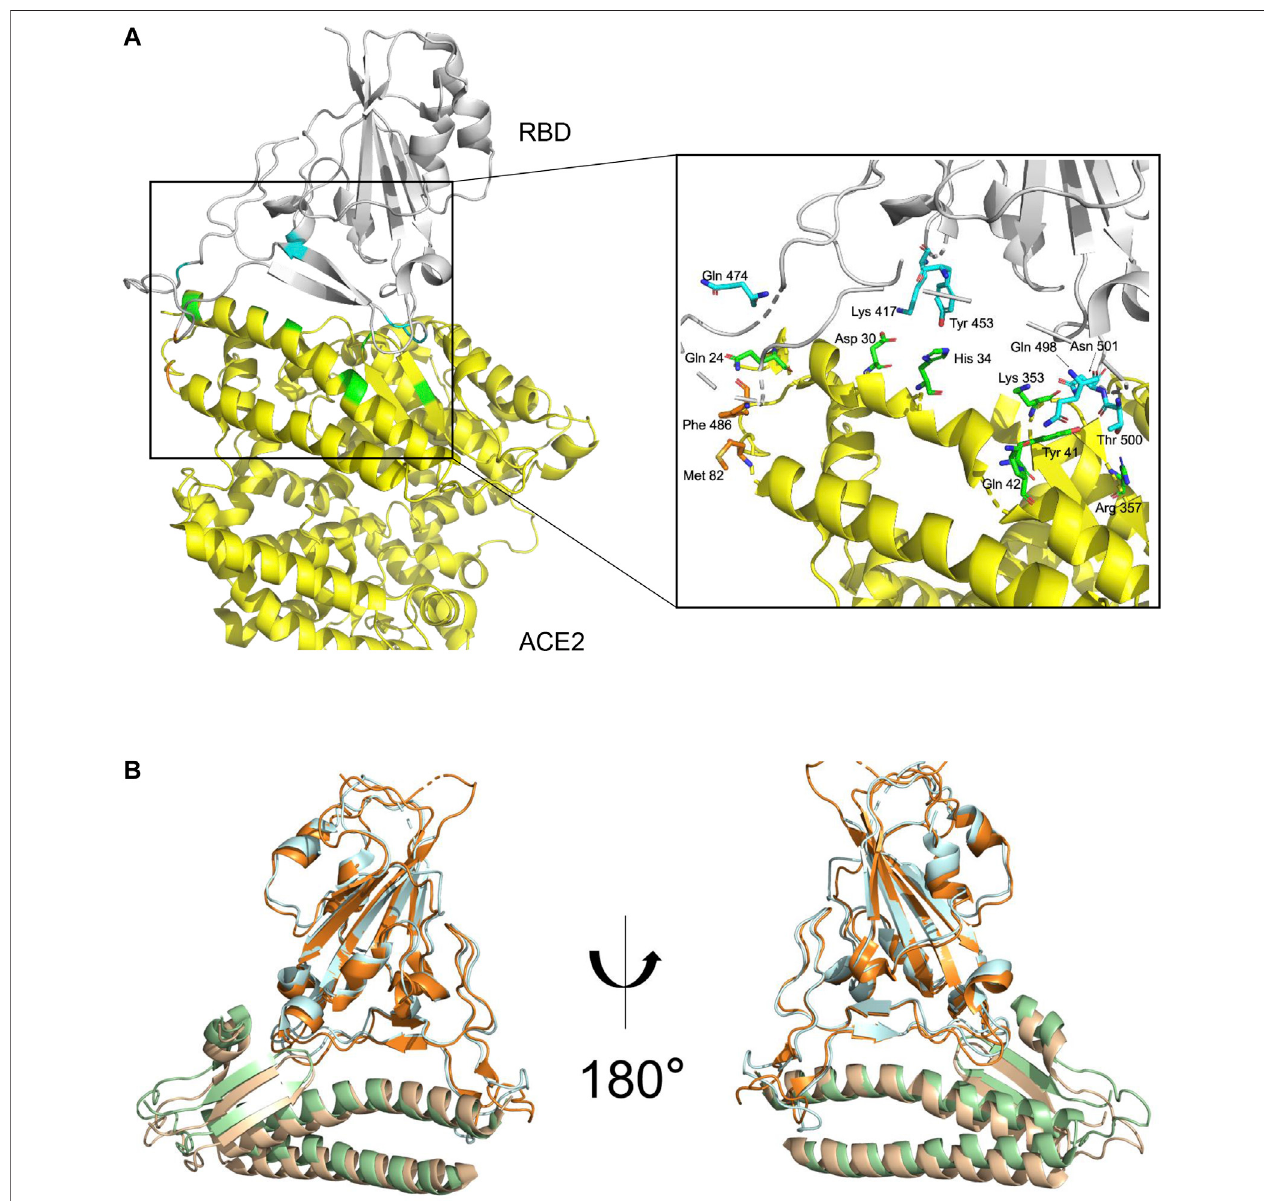
FIGURE 3 | S protein and ACE2 receptor interaction. (A) . The complex structure of RBD – ACE2 demonstrating the interactions between SARS-CoV-2 RBD (gray) and ACE2 (yellow) with key residues on RBD and ectodomain of ACE2 shown in blue and green, respectively. Images generated based on PDB 6M0J. (B) . Structural superimpose of the SARS-CoV-2-RBD/ACE2 and SARS-CoV-RBD/ACE2 complexes. SARS-CoV-RBD and ectodomain of ACE2 are colored in cyan and green, respectively. SARS-CoV interactions were generated based on PDB 2AJF.